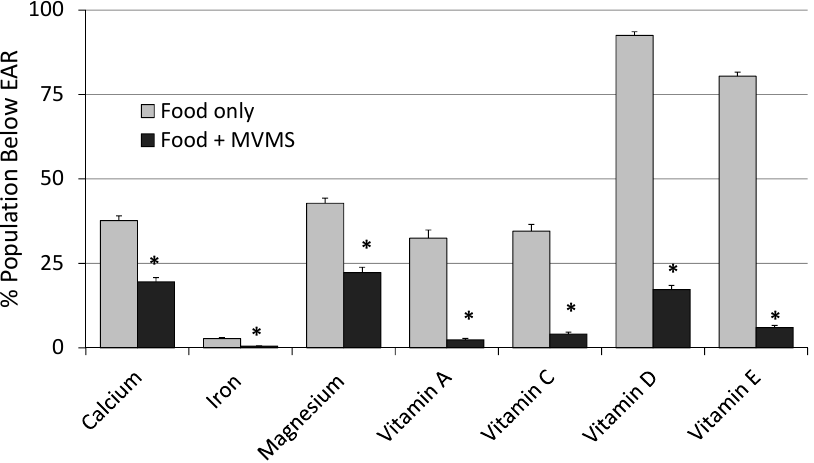
Figure 1. Prevalence of inadequacy (% of population below EAR) for “underconsumed nutrients” identified in 2015–2020 Dietary Guidelines for Americans from food only and food + MVMS among adults age 19 years and older reporting taking a MVMS. NHANES 2009–2012. * Significantly different from Food only at p < 0.01. EAR: estimated average requirement; MVMS: multi-vitamin/multi-mineral supplements; NHANES: National Health and Nutrition Examination